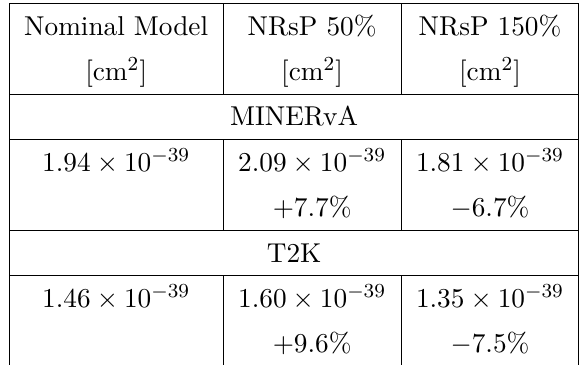
Table 7 . T2K and MINERvA CC0 π 1p total cross-section obtained using NRsP (proton re- scattering probability) configurations of 50% and 150%. We use the dσ/d ( δα tribution to perform the numerical integrations. In percentage, we also show the relative variation with respect to the nominal